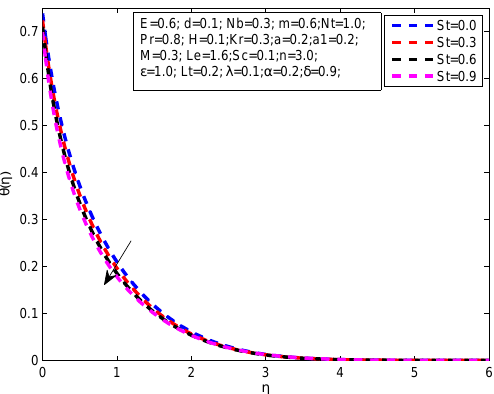
Figure 2. Distribution of f (cid:48) for distinct values of St .